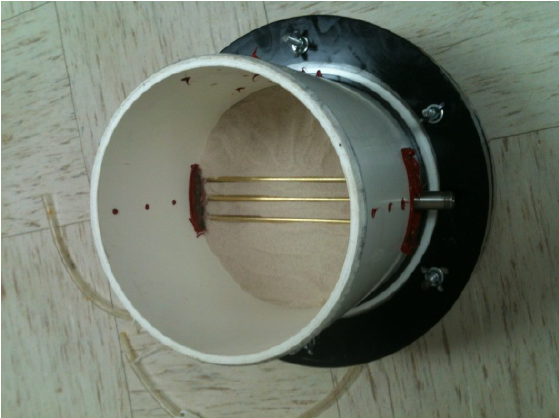
Figure 3. This picture shows the high signal ‐ integrity soil probe flush mounted inside the PVC test